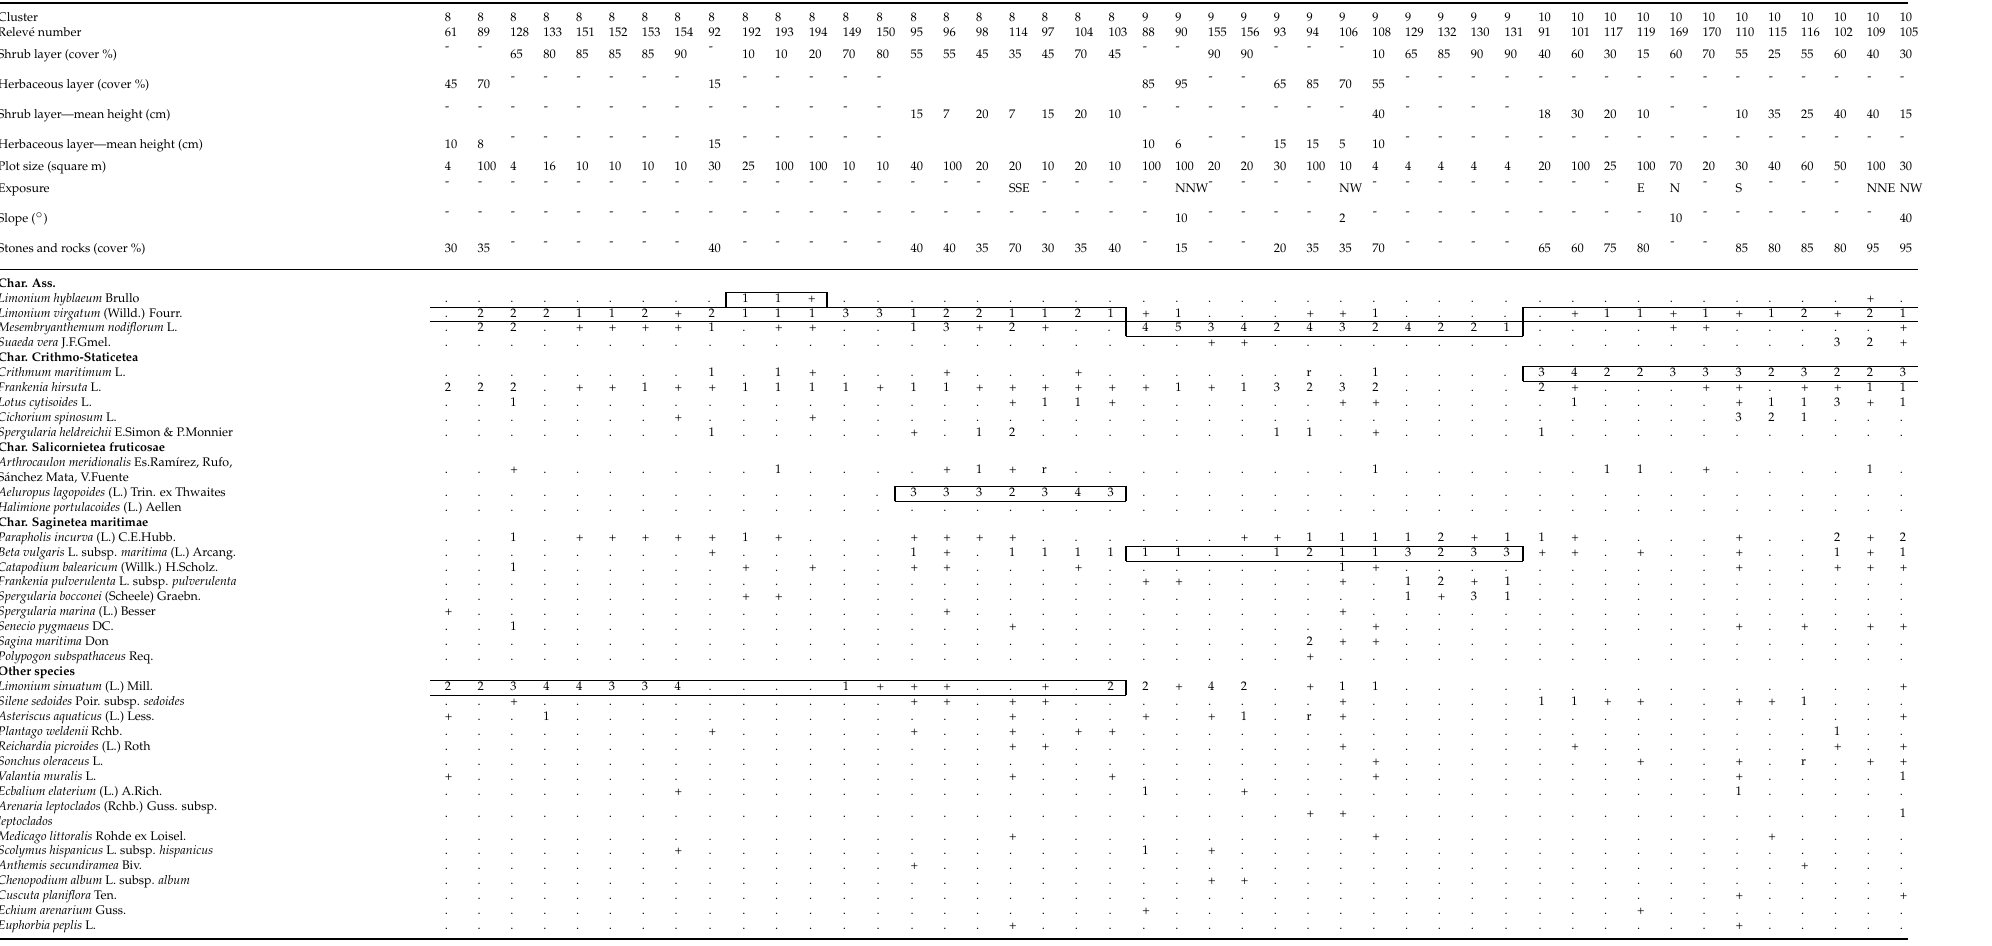
Table A5. Phytosociological relev é s from the Island of Capo Passero (SE Sicily)—rocky coast vegetation.